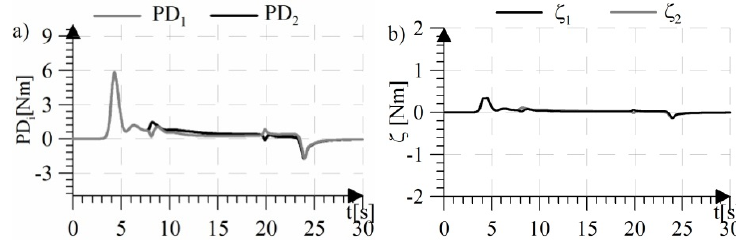
Figure 3: The course of control signals with the aid of the PD regulator and the robust control signal.